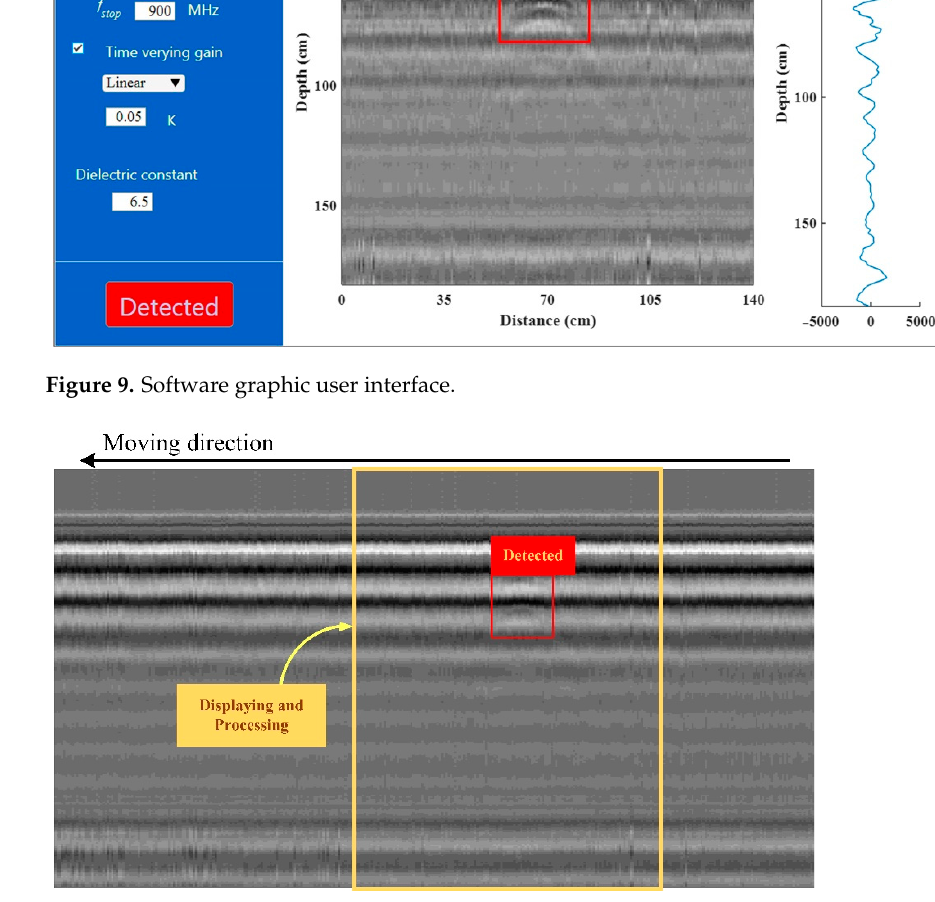
Figure 9. Software graphic user interface.